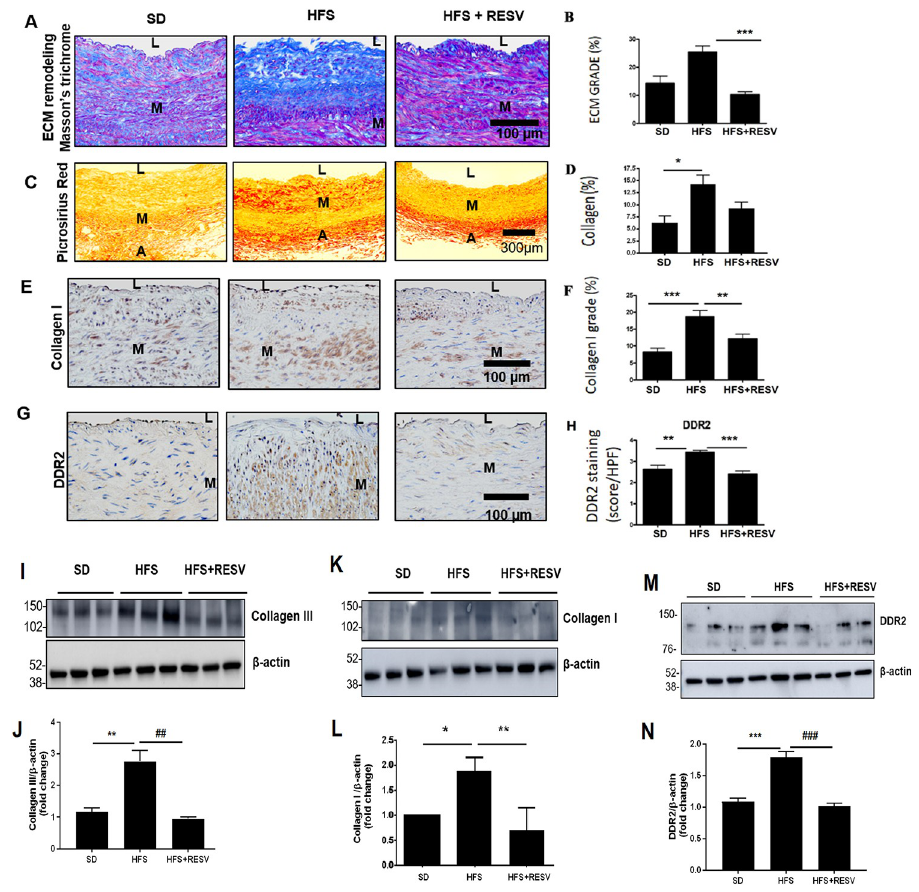
Fig 9. HFS-induced alterations in ECM, collagen, and DDR2 in the abdominal aortic wall. (A) Representative photomicrographs of Masson’s trichrome staining of paraffin sections (5 μ m) demonstrating extracellular matrix (blue) deposition in the abdominal aorta of rhesus monkeys. (B) Percentage increase in ECM remodeling in SD (n = 4), HFS (n = 10), and HFS+RESV (n = 10) presented as Mean ± SEM. 4 consecutive cross sections were analyzed. One-way ANOVA Kruskal-Wallis with Post hoc Dunn’s test, ��� p < 0.001 vs. HFS. (C) Representative photomicrographs of Sirius red staining of paraffin sections (5 μ m) that demonstrate total collagen in the abdominal aorta of rhesus monkeys. (D) Percentage increase in total collagen in SD (n = 4), HFS (n = 10), and HFS+RESV (n = 10) presented as Mean ± SEM. 4 consecutive cross sections were analyzed. One-way ANOVA Kruskal-Wallis with Post hoc Dunn’s test, � p < 0.05. (E) Representative photomicrographs of type I collagen immunostaining of paraffin sections (5 μ m) that demonstrate collagen type I deposition in the abdominal aorta of rhesus monkeys. (F) Percentage increase in collagen type I in SD (n = 4), HFS (n = 10), and HFS+RESV (n = 10) presented as Mean ± SEM. 4 consecutive cross sections were analyzed. One-way ANOVA Kruskal-Wallis with Post hoc Dunn’s test. ��� p < 0.001 vs. SD, �� p < 0.01 vs. HFS. (G) Representative photomicrographs of DDR2 immunostaining (brown) of frozen sections (5 μ m) demonstrating DDR2 expression in the abdominal aorta of rhesus monkeys. (H) Data of the scoring of DDR2 protein signal in SD (n = 4), HFS (n = 10), and HFS+RESV (n = 10) presented as Mean ± SEM. 4–6 consecutive cross sections were analyzed. One-way ANOVA Kruskal-Wallis with Post hoc Dunn’s test �� p < 0.01 vs. SD, ��� p < 0.001 vs. HFS. (I-N) Expression levels of collagen types I and III, and DDR2, in the abdominal aorta from SD, HFS and HFS +RESV-fed rhesus monkeys were analyzed by western blotting. For collagen type III— �� p < 0.01 vs. SD, ## p < 0.01 vs. HFS. For collagen type I— � p < 0.05 vs. SD, �� p < 0.01 vs. HFS. For DDR2— ��� p < 0.001 vs. SD, ### p < 0.001 vs. HFS. (One-way ANOVA p < 0.05). Data are representative of 3 independent experiments with SD, n = 3. Error bars represent SD.SD = Standard Diet, HFS = High Fat Sucrose Diet, HFS+RESV = High Fat Sucrose Diet with resveratrol treatment. L = Vascular Lumen, M = Vascular medium, A = Vascular